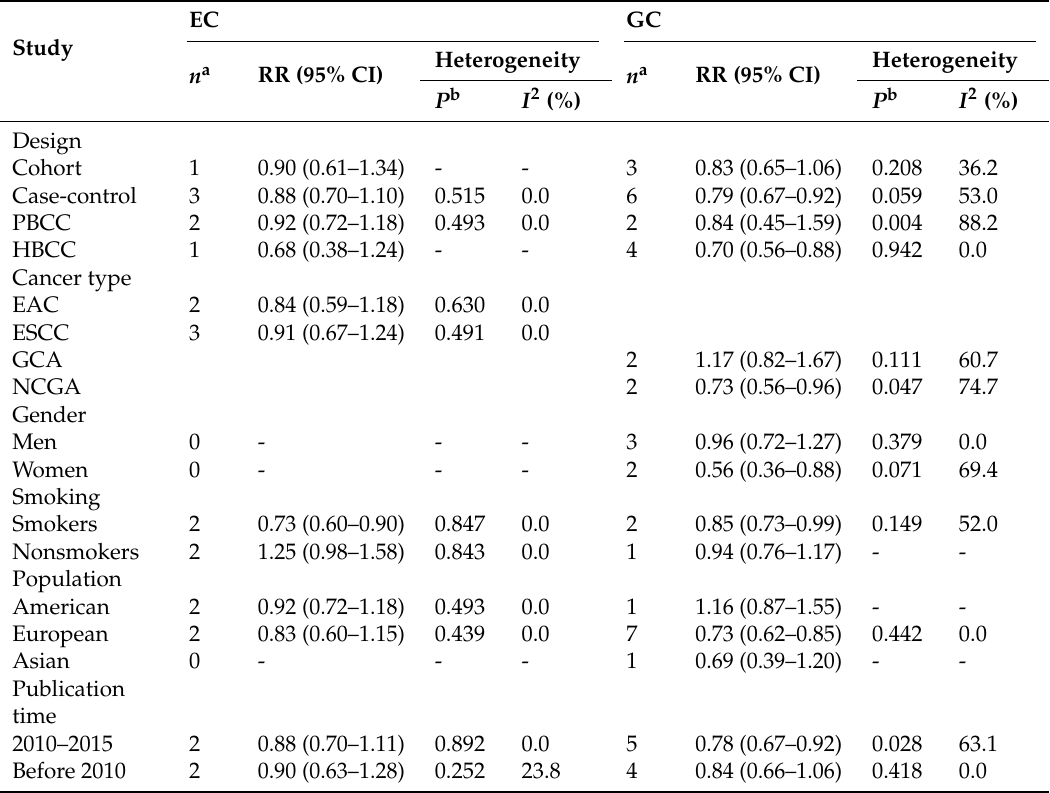
Table 2. Summary estimates of dietary flavonols (highest vs. lowest) and esophageal and gastric cancer